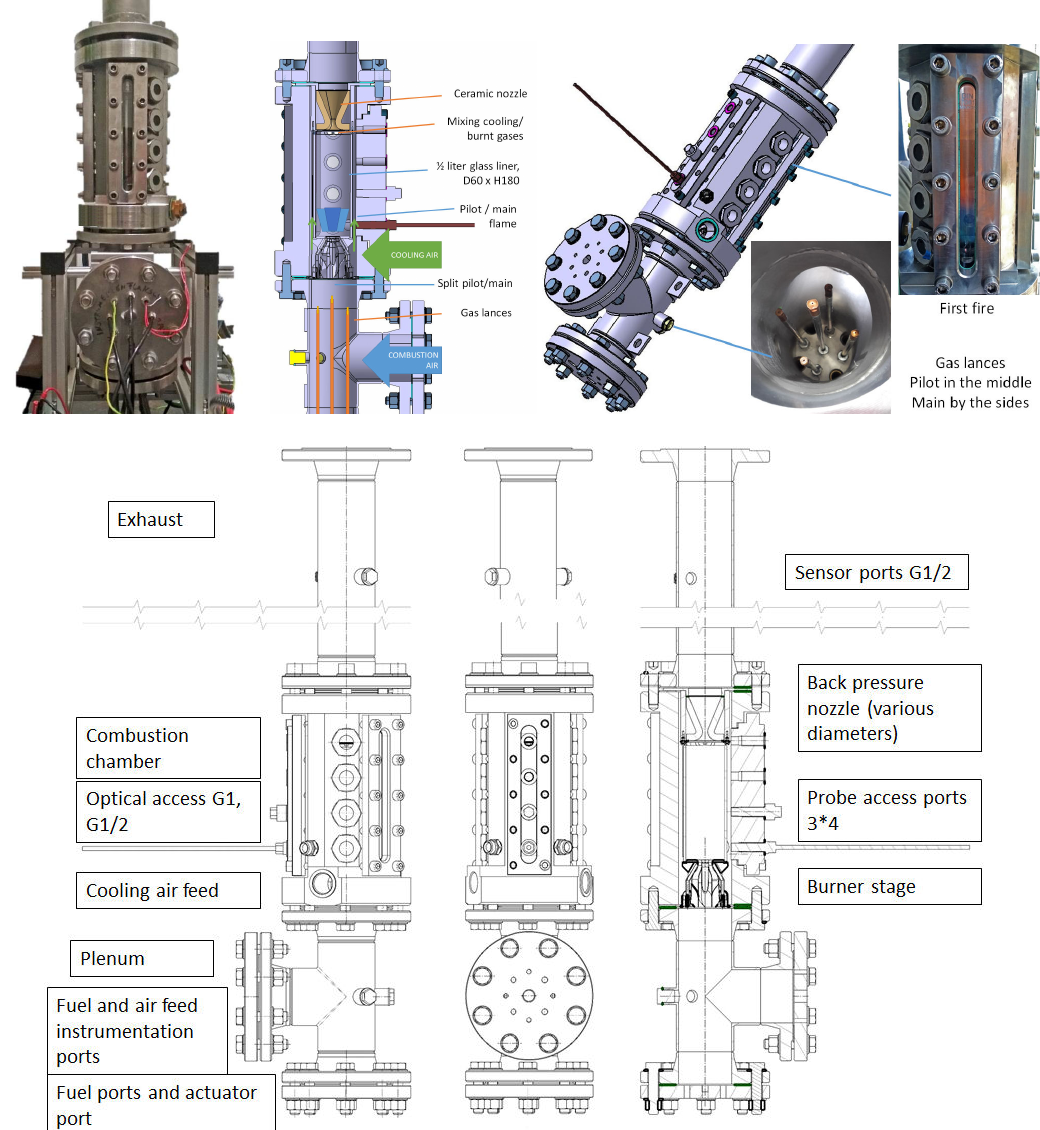
Figure 10. The emootion test rig: ( top ) view and details of the flow paths and ( bottom ) structure and